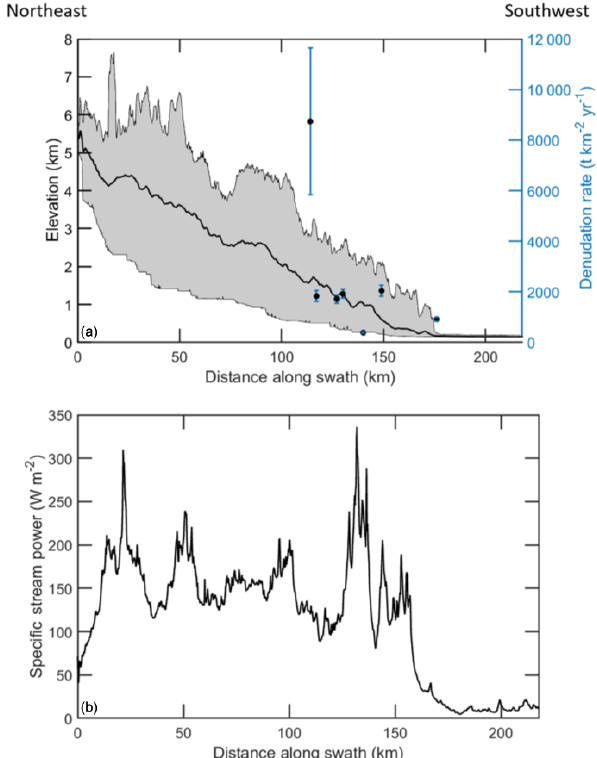
Figure 2. (a) Profiles of mean elevation (black line) and range of minimum to maximum elevations (gray shaded region) perpendic- ular to the Himalayan range front along the swath shown in Fig. 1. Black circles show denudation rate estimates (Table 2) and loca- tions of sediment samples. (b) Profile of mean specific stream power along the same